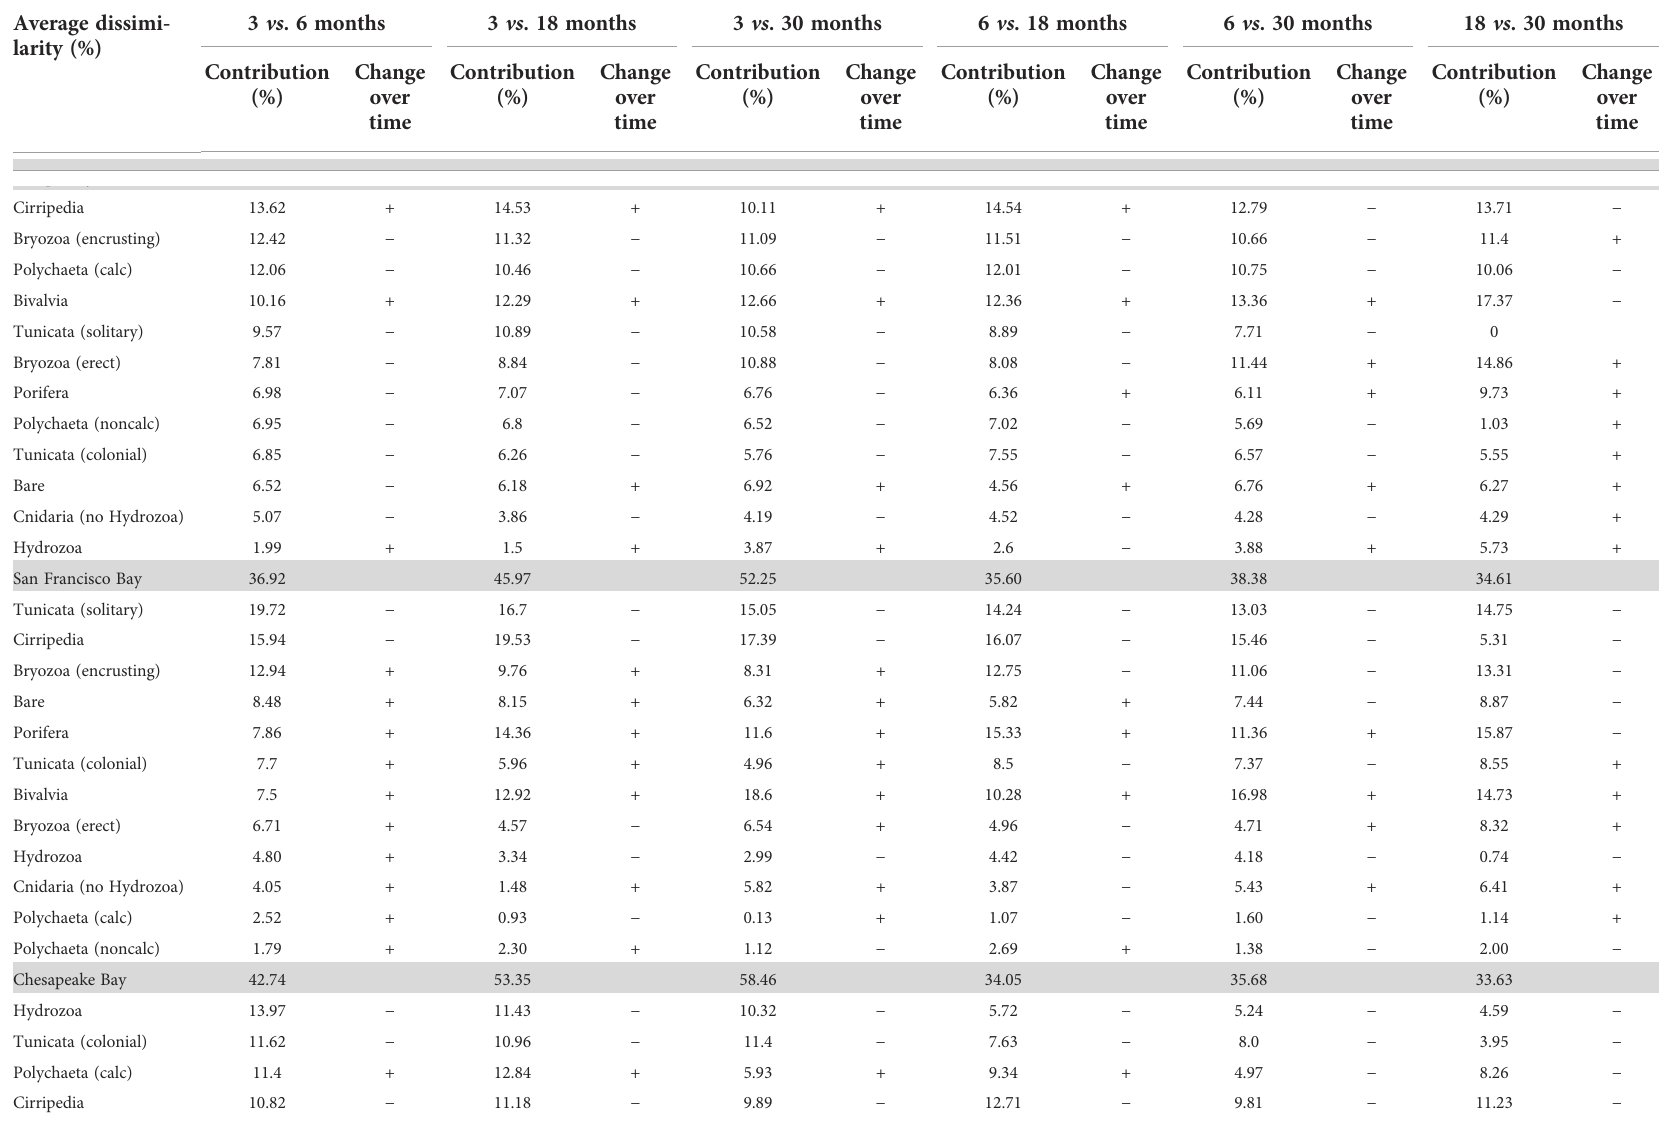
TABLE 3 Average SIMPER dissimilarity (%) of functional community composition by Bay-speci fi c functional groups deployed for 3-, 6-, 18-, and 30-month residence times (period 1). Average dissimi- larity